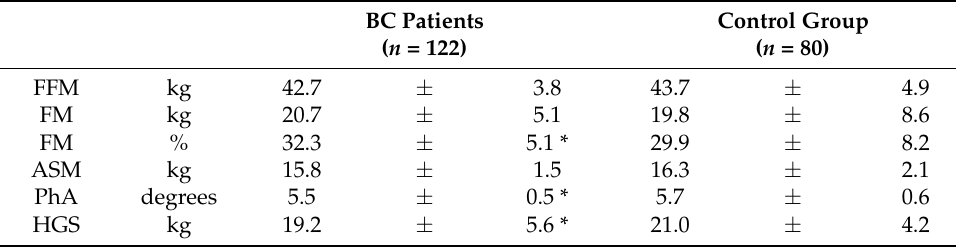
Table 3. Body composition and hand grip strength measurements.